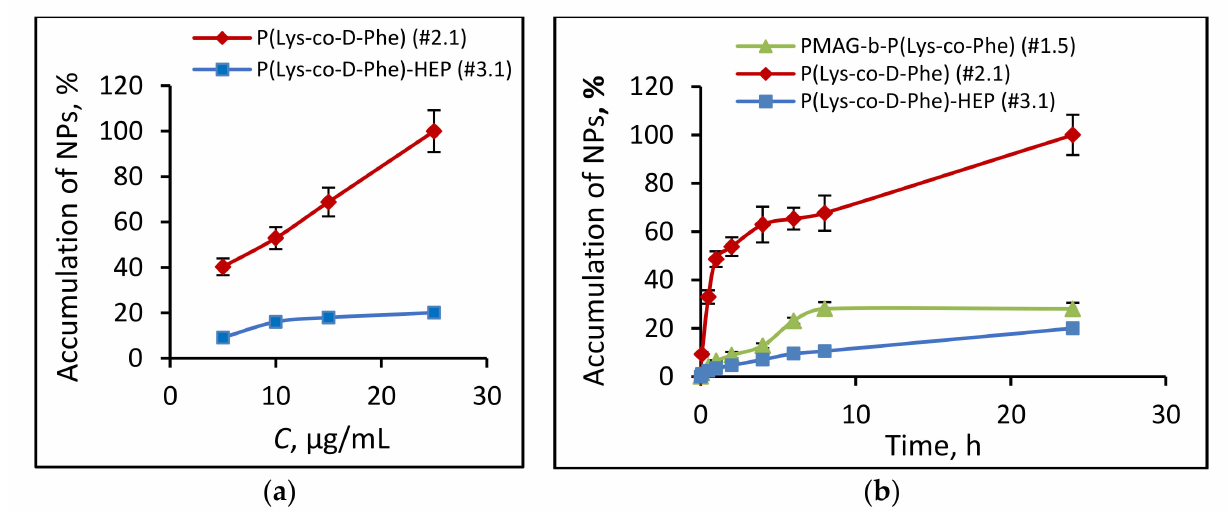
Figure 9. Dependence of NPs accumulation on their concentration (t = 24 h) ( a ) and kinetics of cell uptake of Cy 3 -labeled NPs ( b ): P(Lys- co - D -Phe) (sample #2.1), (P(Lys- co - D -Phe)-HEP (sample #3.1) and PMAG- b -P(Lys- co -Phe) (sample #1.5) NPs ( C NPs = 25 µ g/mL, C Cy3 = 50 µ g/mg of NPs, A549 cells). The compositions of different polymer samples are provided in Table 2.